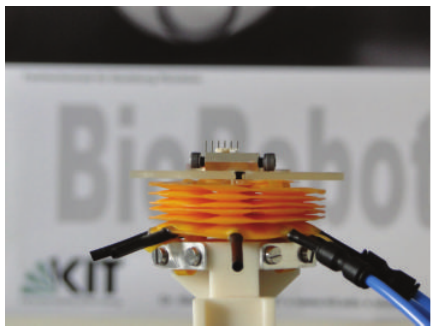
Figure 5: Actuator for internal rotation without pressure.